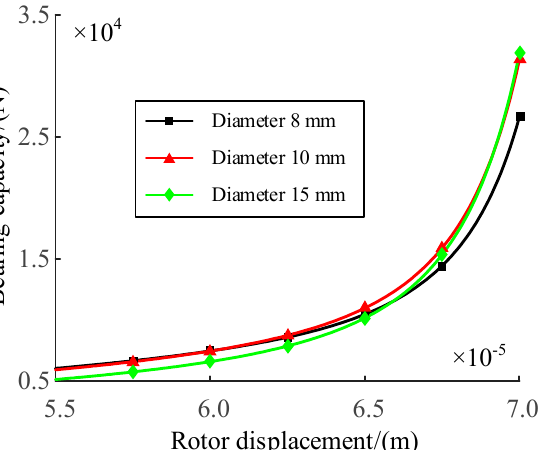
Figure 6. Curves of bearing capacity and rotor displacement system under different bearing cavity diameters.